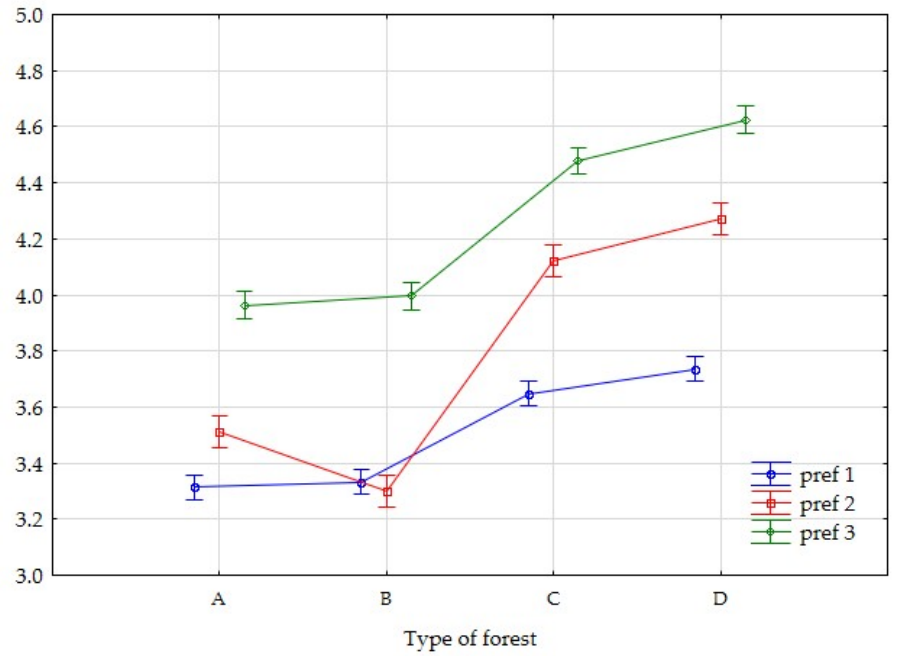
Figure 3. Relation between forest development level and its preference level.